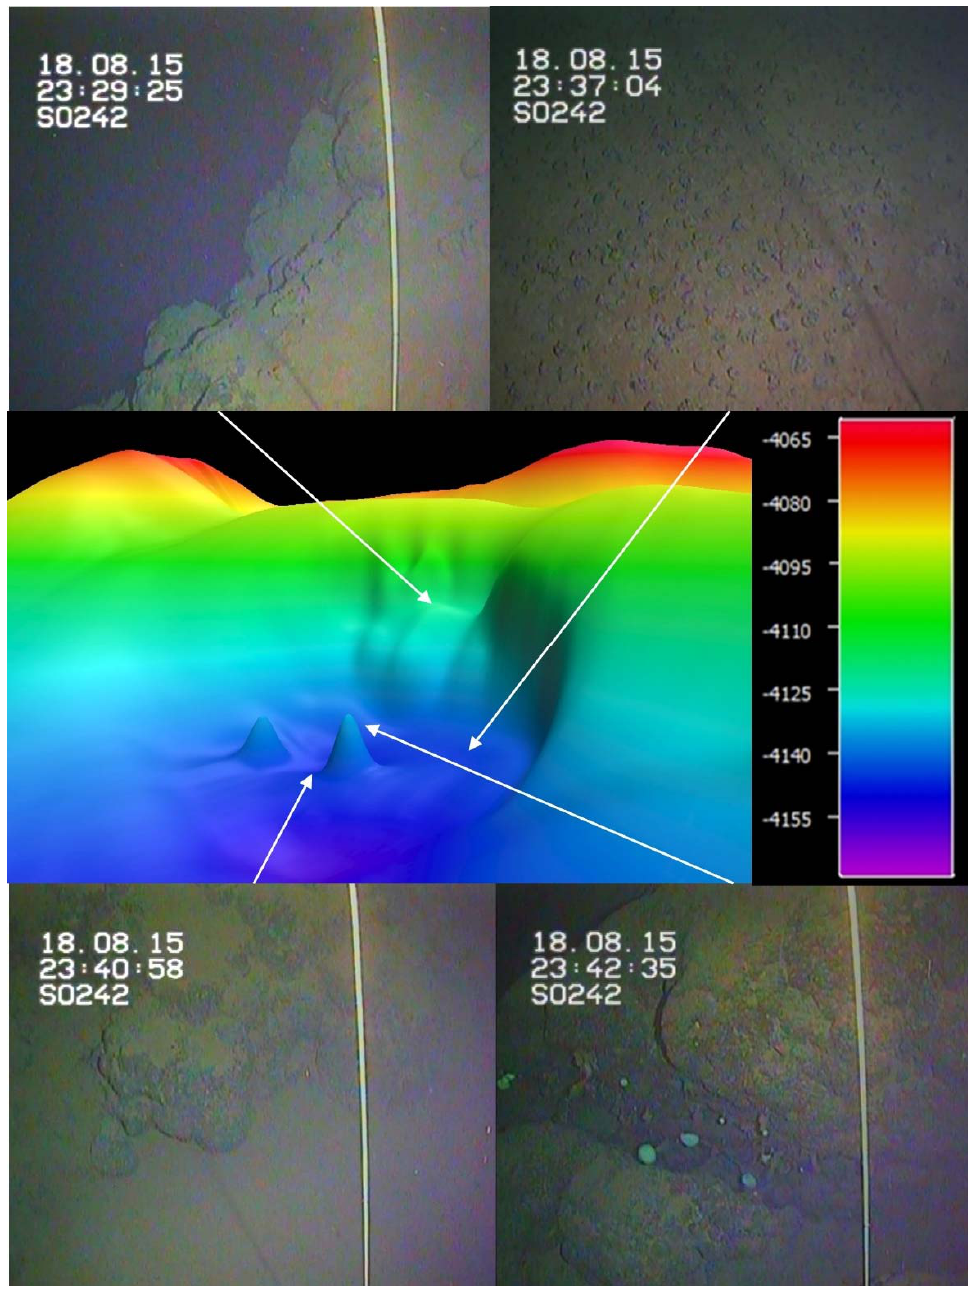
Figure A2. Examples of OFOS photos (SO242-1_135_OFOS06) inside the crate-shaped structure with two outcropping volcanic cones of pillow basalts (DEA-NE). Top left: the short hillcrest with increased slopes; top right: PMN mixed with talus debris in the foot slope and crater floor; middle: 3D bathymetric representation (exaggerated ×5); bottom: the base of the volcanic cone (left) and the summit (right).